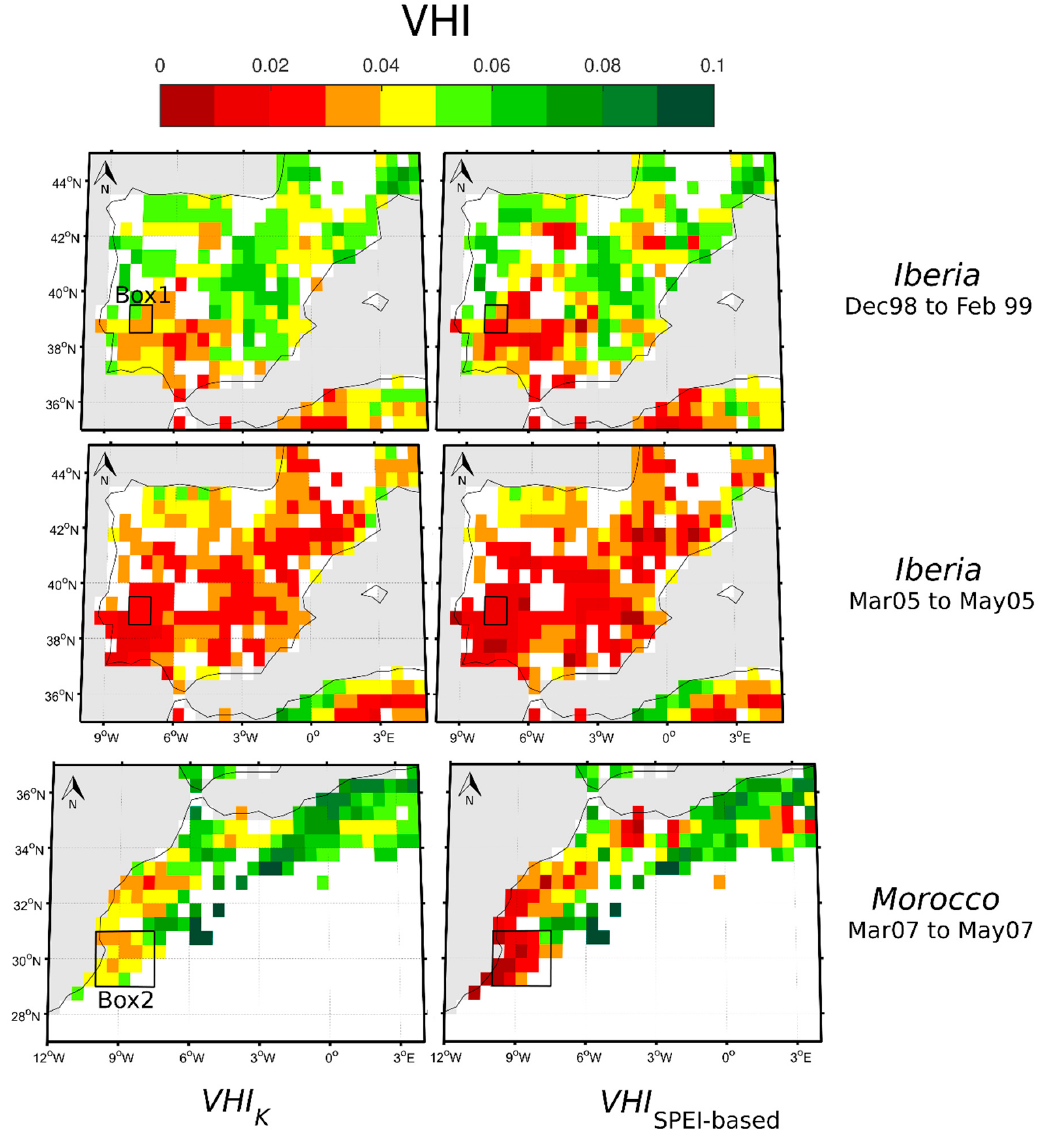
Figure 7. VHI estimated with the traditional Kogan-based method of α = 0.5 (VHI K ; left panels) and with the SPEI-based rationale (VHI SPEI-based ; right panels) for three drought episodes: Southern Iberia in winter 1998/1999 ( top ); Iberia in spring 2005 ( middle ); and Morocco in spring 2007 ( bottom ).